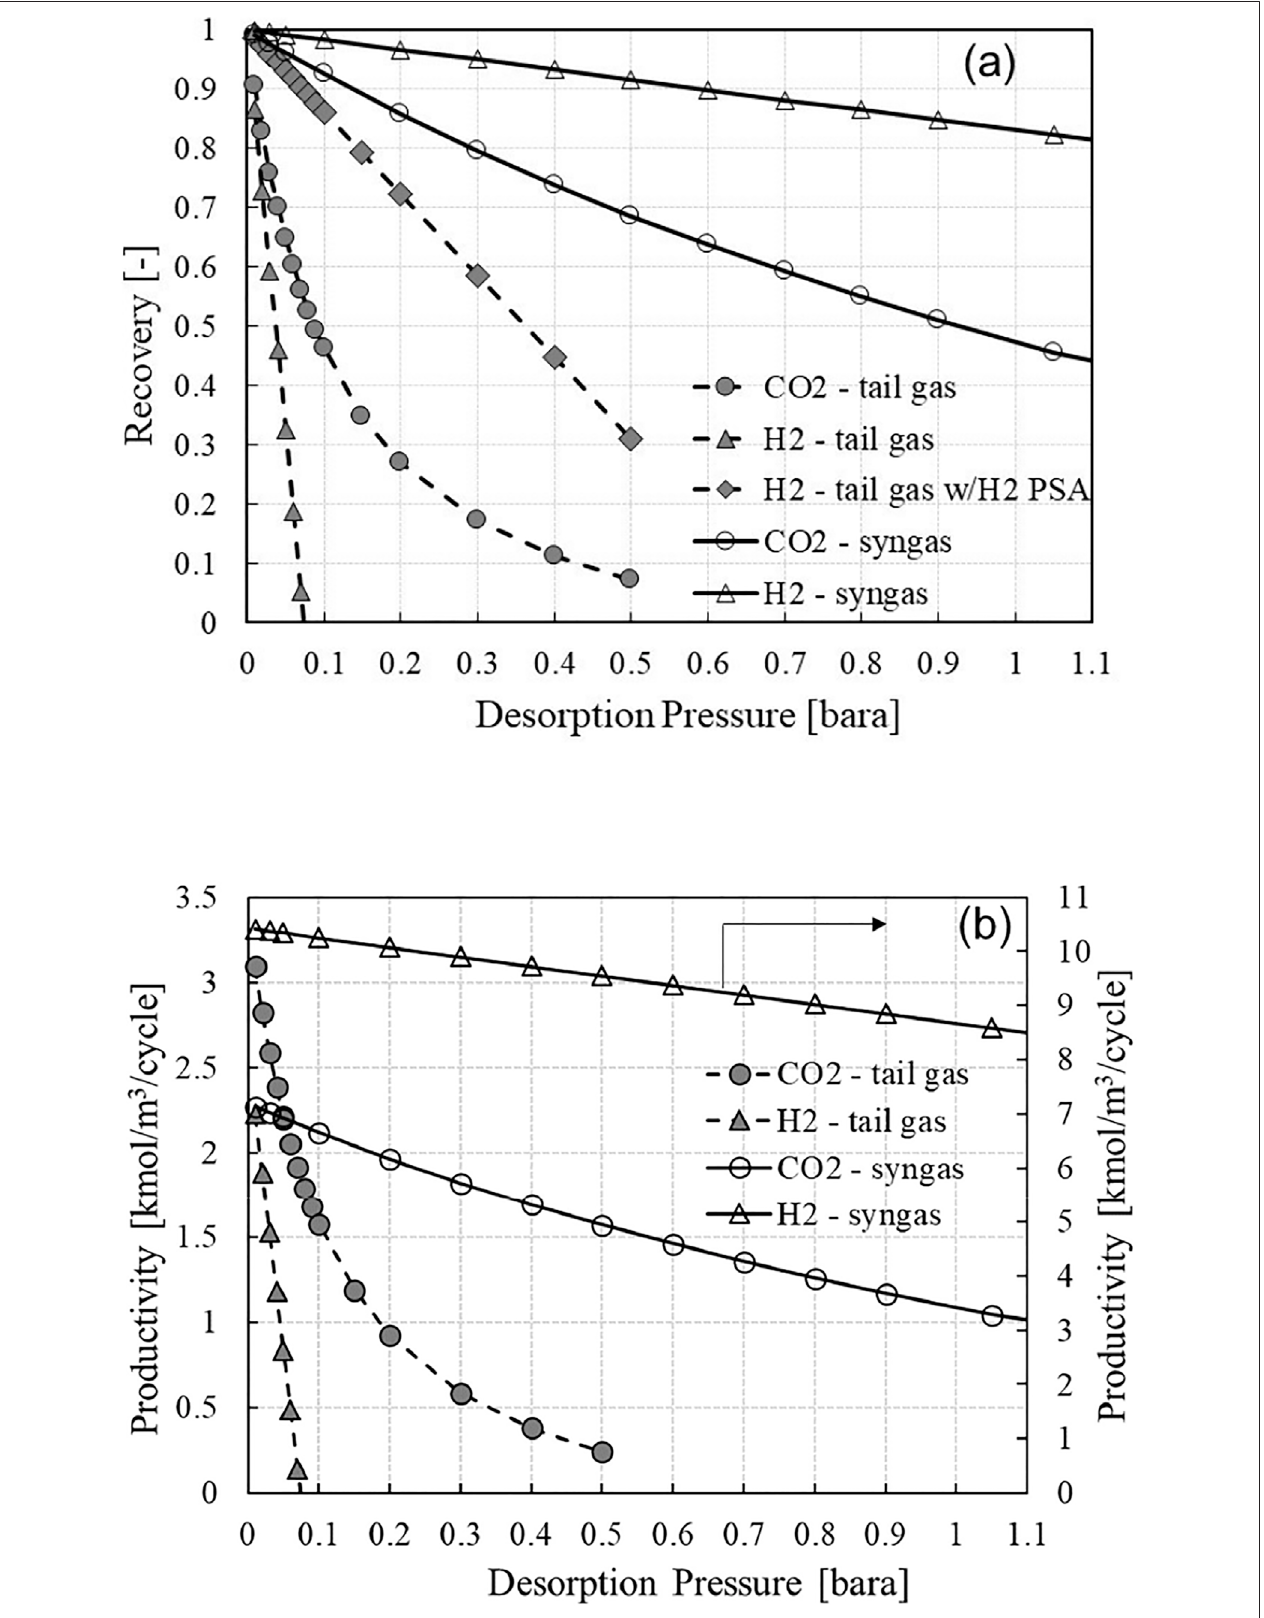
FIGURE 6 | Effect of desorption pressure on (A) product recovery and (B) bed productivity. Frontiers in Chemical Engineering |